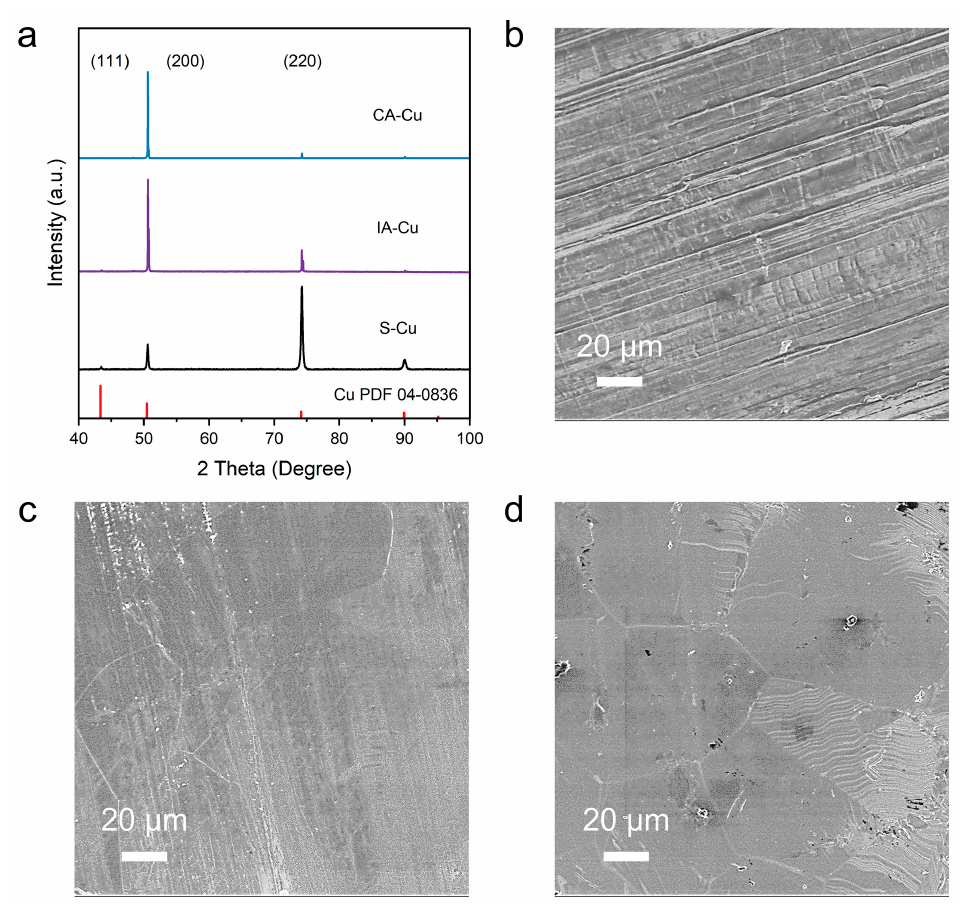
Figure 1. Characterization of samples S-Cu, IA-Cu, and CA-Cu. ( a ) XRD patterns and SEM images of samples S-Cu ( b ), IA-Cu ( c ), and CA-Cu ( d ).